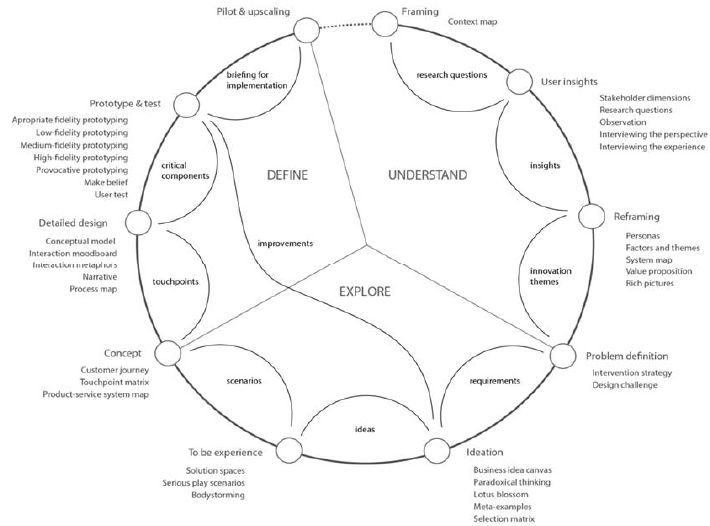
Figure 3. PSS design toolkit overview. Figure 3.